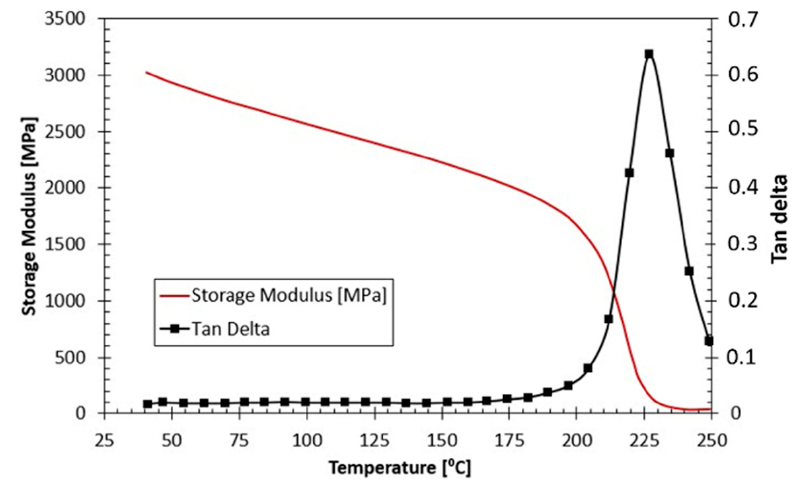
Figure 1. DMA results, that is, tan delta and storage modulus, of the RTM6 epoxy resin. The cured cylindrical rods of the resin were cut into disk-shaped samples, with 8 mm diameter and 4 mm height (i.e., height to diameter ratio is 0.5), as shown in Figure 2. Identical samples and loading conditions were used for both reference quasi-static and high strain rate tests, in order to eliminate any discrepancies related to sample geometry or size or testing boundary conditions.